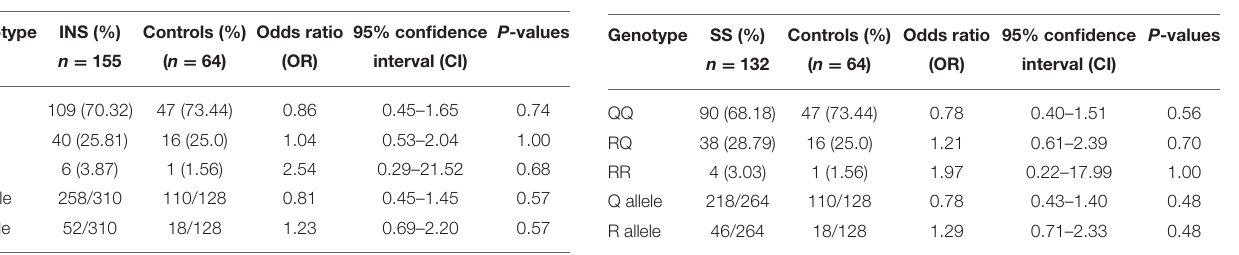
TABLE 8 | Comparison of IL-13 gene polymorphism genotype and allele frequencies between Steroid Sensitive (SS) patients and controls.